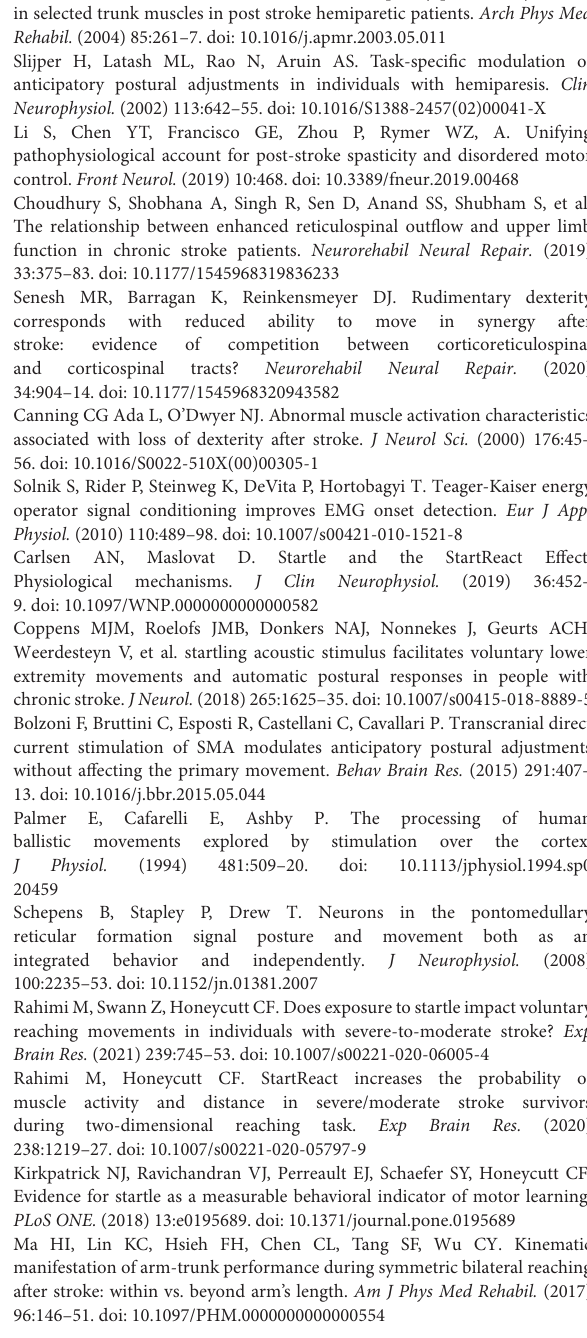
Supplementary Material 1 | Results of liner model and post-hoc comparison of variables. The positive liner model based on data from all subjects and significant